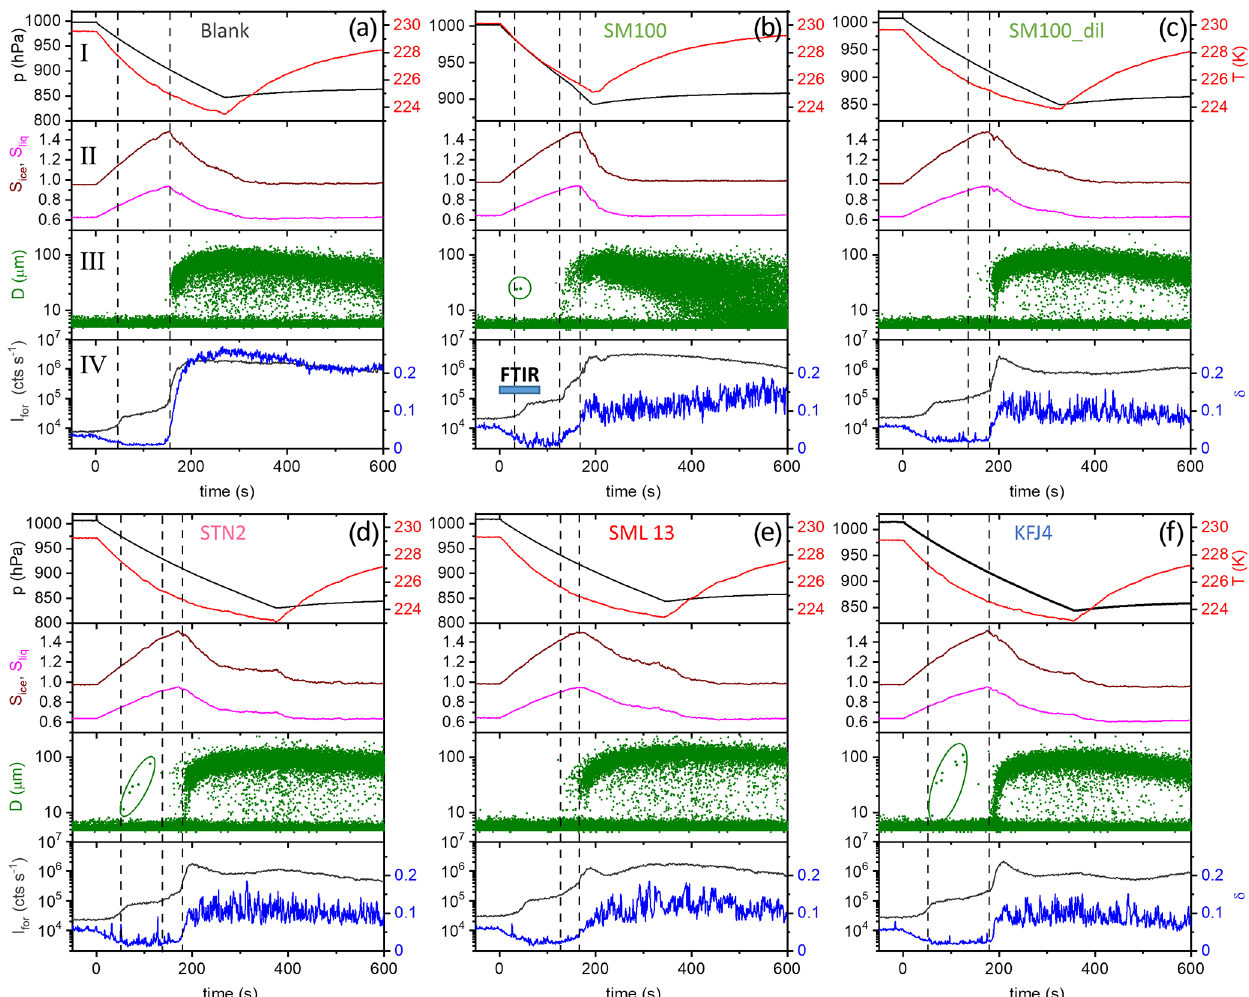
Figure 3. Time series of the AIDA records from the expansion cooling experiments started at 229K for six different samples (a–f) . The sample called “blank” refers to a commercial bulk Atlantic water sample that has already previously been probed in the AIDA chamber (Wagner et al., 2018). The four individual panels for each part show the following data: I: AIDA mean gas temperature (red line) and pressure (black line); II: saturation ratios with respect to ice ( S ice , brown line) and supercooled water ( S liq , magenta line); III: size-resolved single-particle scattering signals from the optical particle counter (green dots); IV: forward-scattering intensity ( I for , 2 ◦ scattering angle, grey line) and backscattering linear depolarisation ratio ( δ , 178 ◦ scattering angle, blue line). The blue horizontal bar in panel IV of Fig. 3b symbolises the time period where the series of FTIR spectra shown in Fig. 4 were recorded. See text for